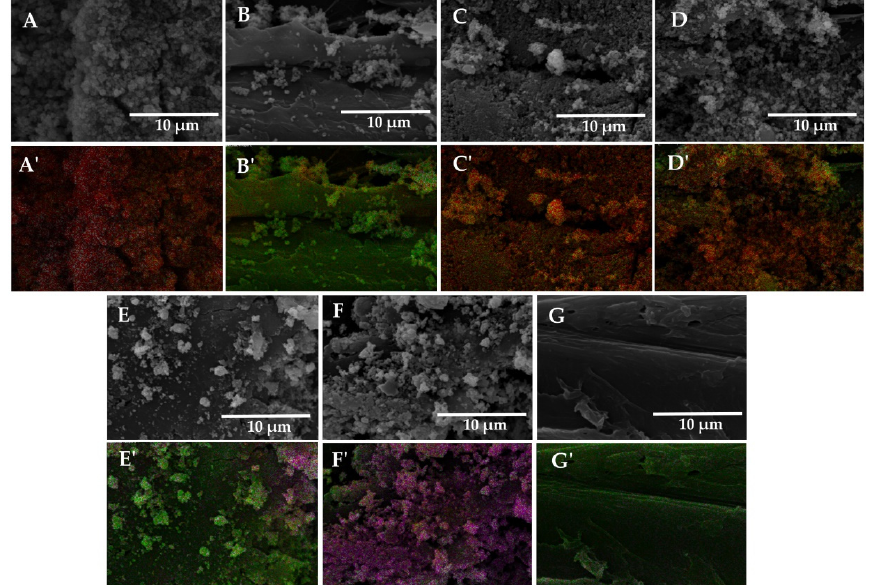
Figure 2. SEM images of wood surfaces treated with ( A ) anatase 40 nm, ( B ) anatase 100 nm, ( C ) rutile 50 nm, ( D ) rutile 100 nm, ( E ) ZnO 35–45 nm, and ( F ) ZnO 80–200 nm and ( G ) untreated control. EDS mapping images of wood surfaces treated with ( A’ ) anatase 40 nm, ( B’ ) anatase 100 nm, ( C’ ) rutile 50 nm, ( D’ ) rutile 100 nm, ( E’ ) ZnO 35–45 nm, and ( F’ ) ZnO 80–200 nm and ( G’ ) untreated control, showing in red, purple, and green the distribution of Ti, Zn, and C, respectively. Images obtained after UV